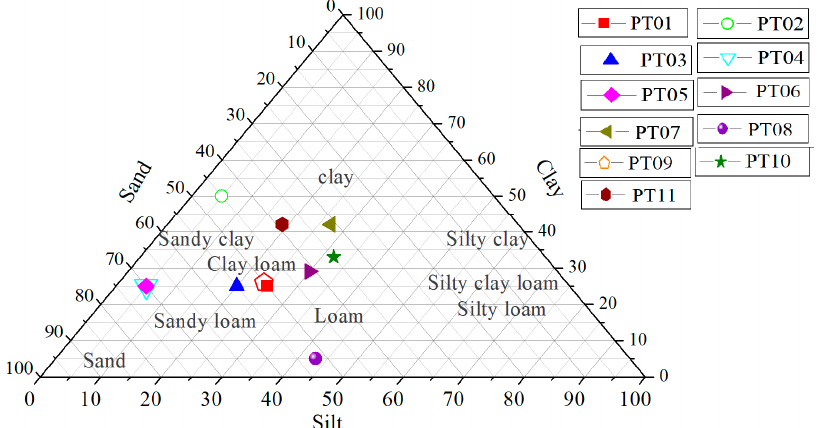
Figure 6. Texture triangle showing proportions of clay, sand, and silt particles of samples at nonfailures (PT01, PT02, PT01, PT02, PT06, PT07, PT08, PT09, PT10, and PT11) and failures, or landslides, sites (PT03, PT04, and PT05); modified from [74,75].